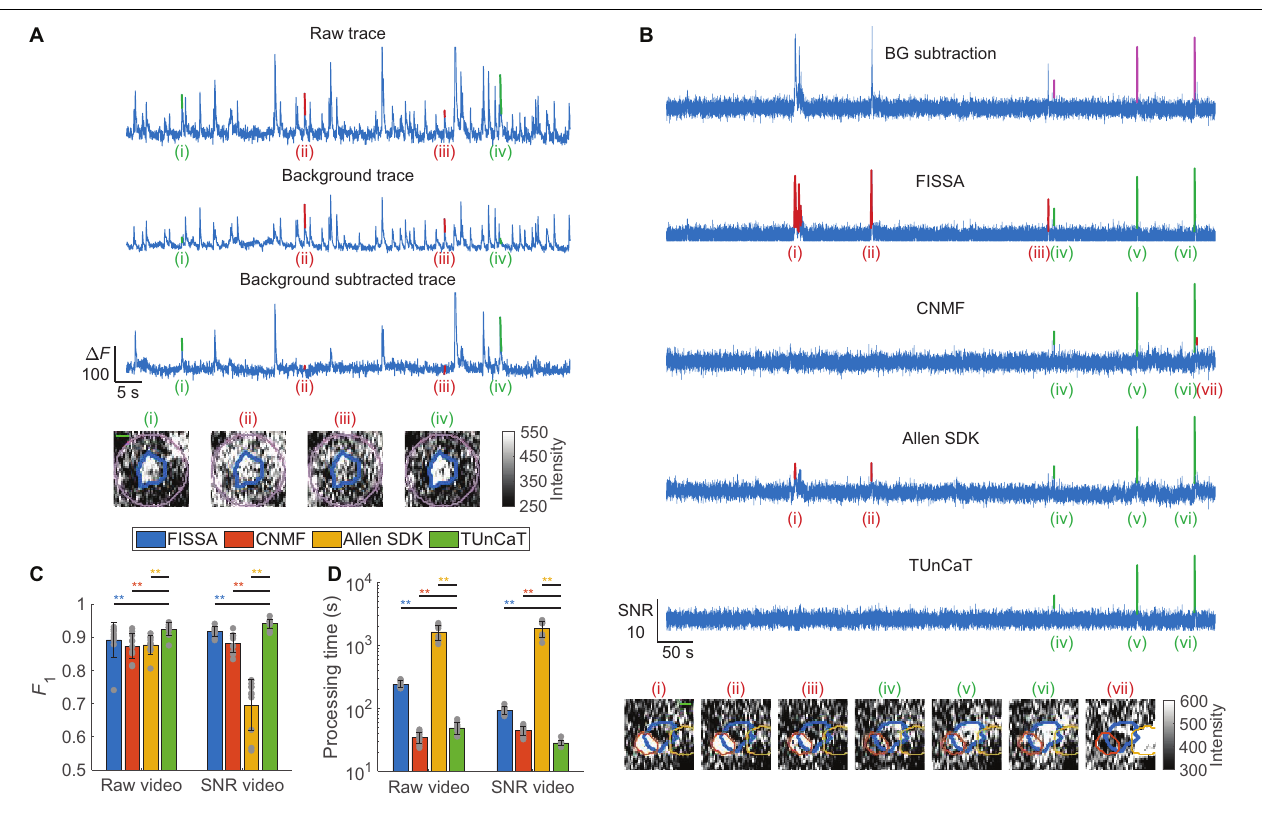
FIGURE 2 | Temporal unmixing of calcium traces (TUnCaT) was more accurate than peer algorithms on experimental two-photon dataset. (A) TUnCaT can remove false transients from the raw trace (top) caused by background fluctuation (middle). The background-subtracted trace (bottom) correctly retained two true neuron transients [(i) and (iv), green] of four example transients detected in the raw trace, and suppressed two transients caused by background fluctuations [(ii) and (iii), red]. Each image below the traces is the corresponding spatial profile of fluorescence at the peak of each transient. The thick blue contour in each image shows the boundary of the neuron, and the purple contour shows the background region surrounding the segmented neuron (scale bar: 5 µ m). (B) TUnCaT can remove false transients caused by neighboring neurons and dendrites for an example neuron. The first trace is the background-subtracted trace of an example neuron representing the trace before unmixing; the magenta transients show the manually determined GT transients. The four remaining traces are the unmixing results of four different methods (FISSA, CNMF, the Allen SDK, and TUnCaT) from that neuron. Subpanels (i)–(vii) show example transients detected by at least one unmixing algorithm. The neuron transients correctly identified by each algorithm are highlighted green, while transients incorrectly identified by each algorithm as false positives are highlighted red. Transients (i)–(iii) came from a neighboring neuron, and transient (vii) came from a dendrite. Each image below the traces is the corresponding spatial profile of fluorescence at the peak of each transient. The thick blue contour in each image shows the boundary of the neuron, and the orange and yellow contours show the boundary of two different neighboring neurons (scale bar: 5 µ m). (C) The F 1 scores of TUnCaT during 10-round cross-validation were superior to that of the other methods both when processing raw videos and when processing SNR videos (** p < 0.005, two-sided Wilcoxon signed-rank test, n = 10 videos; error bars are standard deviations). The gray dots represent scores for the test data on each round of cross-validation. (D) The processing time of TUnCaT was comparable to or faster than the other methods both when processing raw videos and when processing SNR videos (** p < 0.005, two-sided Wilcoxon signed-rank test, n = 10 videos; error bars are standard deviations). The gray dots represent the processing times of the test data on each round of